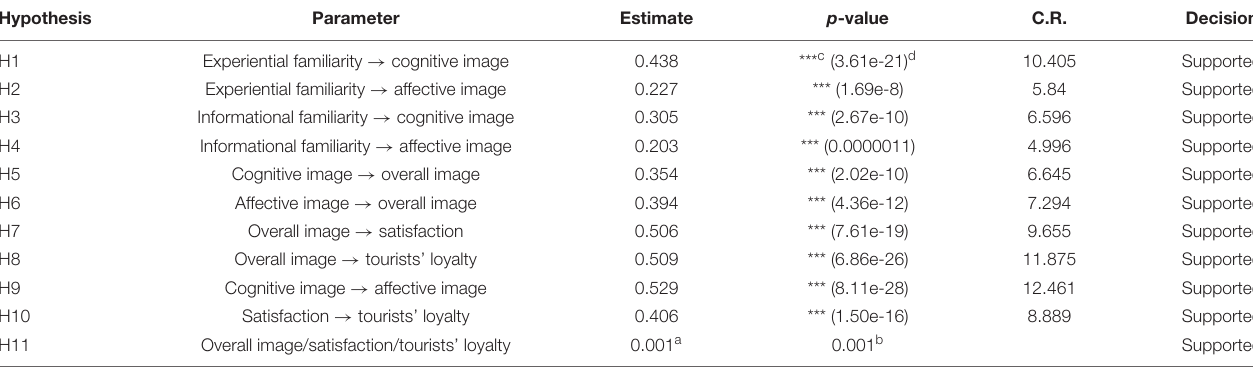
FIGURE 2 | The structural model outcomes. ∗∗∗ denotes p -value < 0.001. TABLE 4 | Regression results of structural